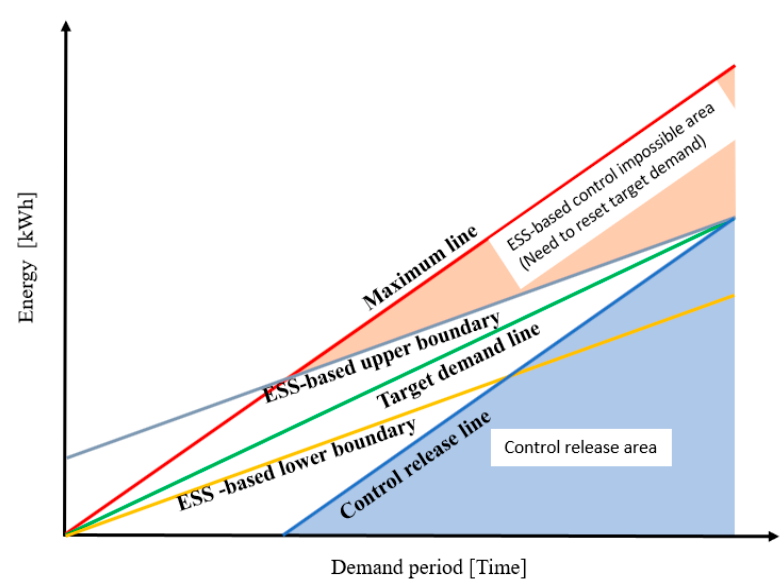
Figure 4. Operational boundaries of the ESS-based control.